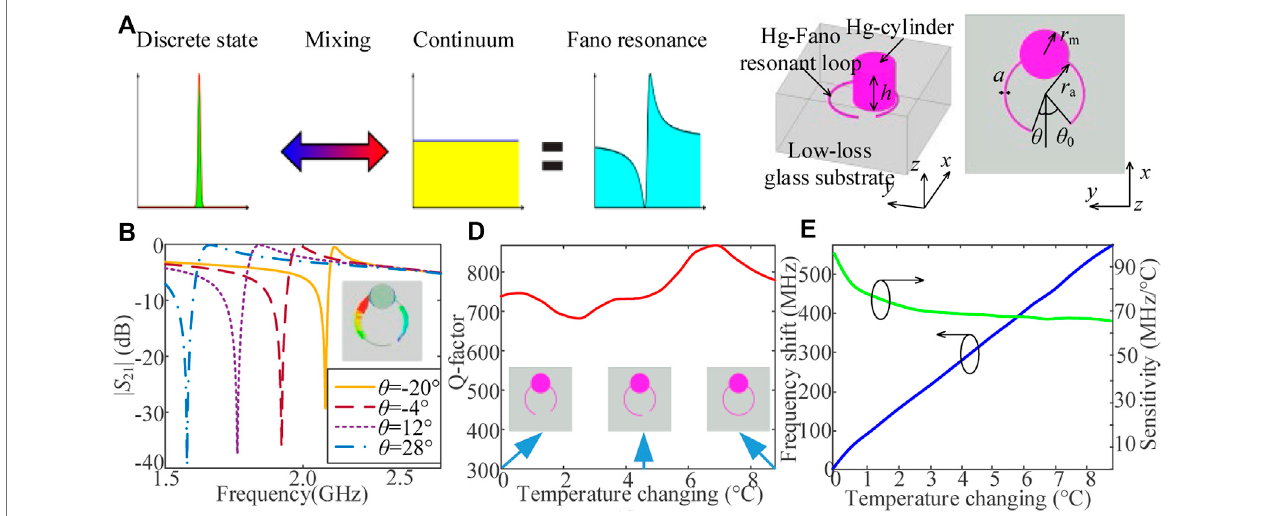
FIGURE1|(A) TheoreticalpresentationoftheFanoresonance, (B) the3D/2DviewofthedesignedHg-Fanoresonatorwithparameterde fi nitions, (C) transmission curvesoftheHg-Fanoresonatorunderdifferentparameter θ valuesobtainedbynumericalsimulationintheperiodboundarycondition,and (D,E) thecalculatedQ-factor, resonant frequency shift, and temperature sensing sensitivity as a function of temperature changings. The modeled surface current distributions at Fano resonance frequency are shown in the inset in panel of (C) .